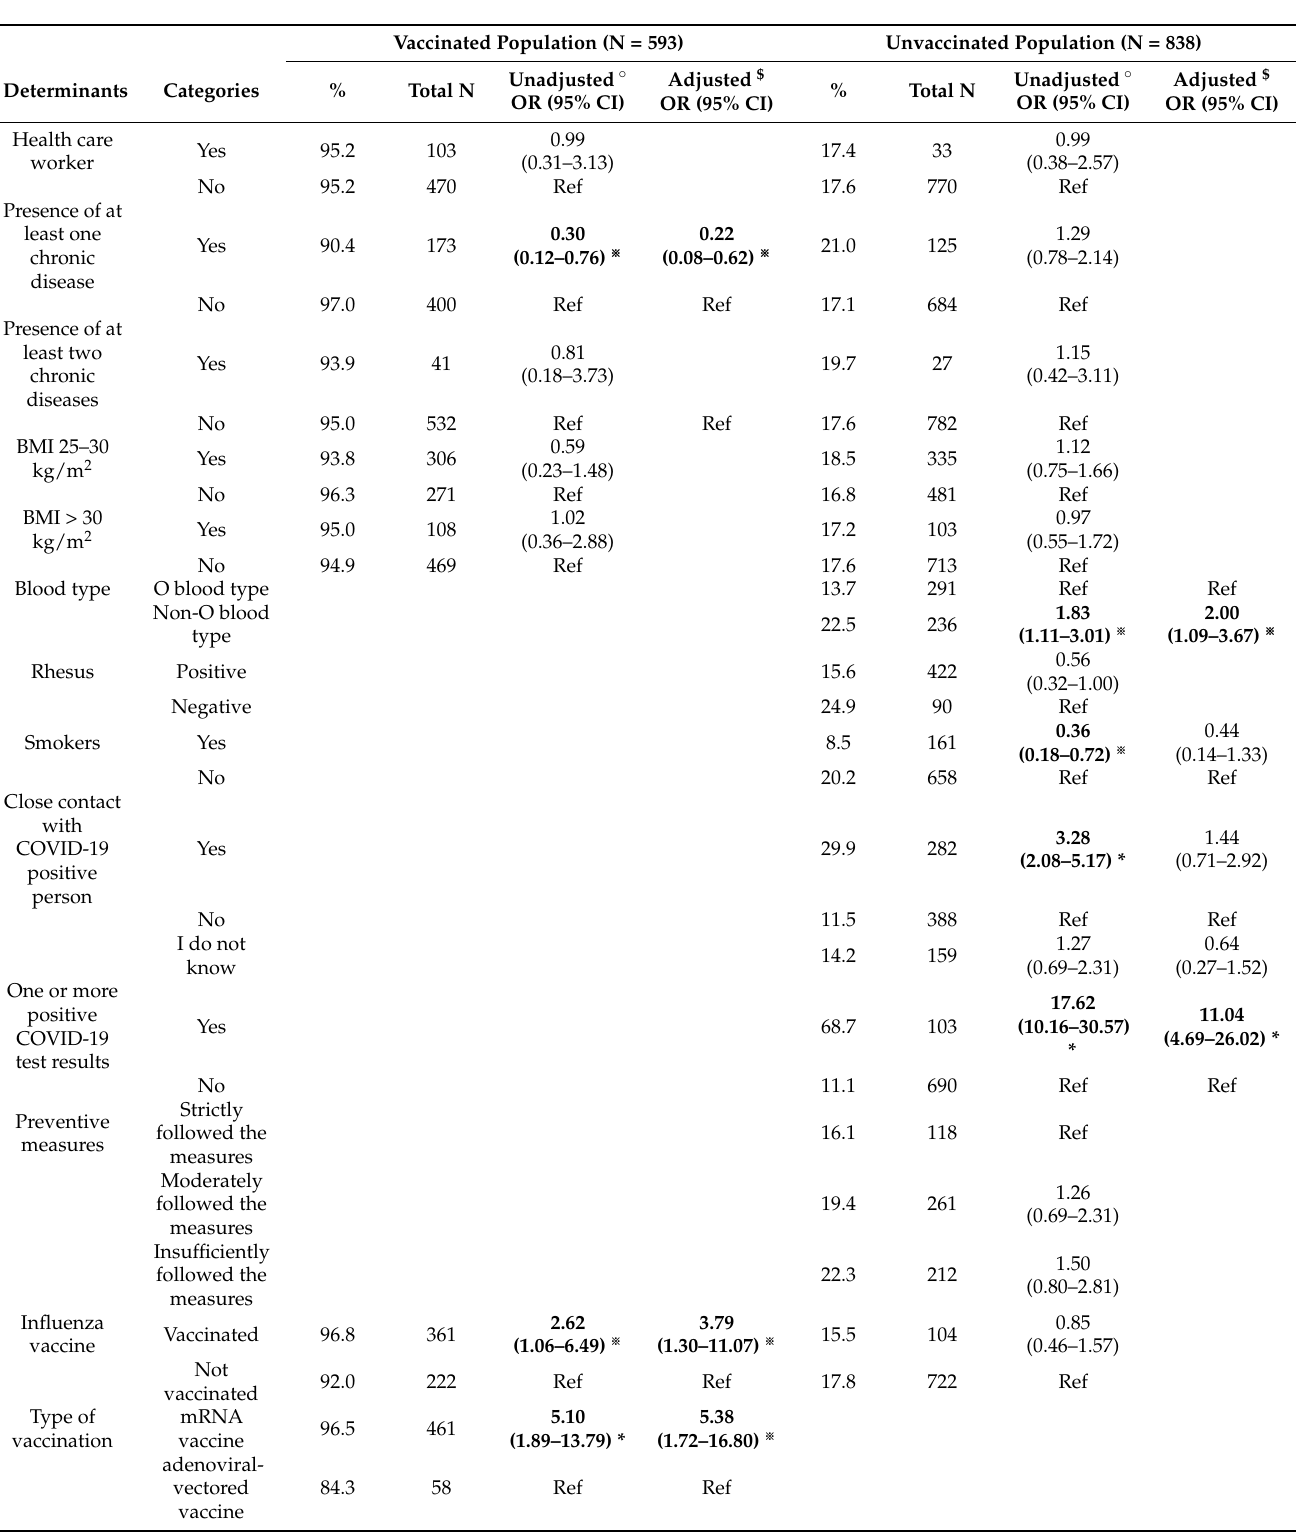
Table 3. Cont . Vaccinated Population (N =